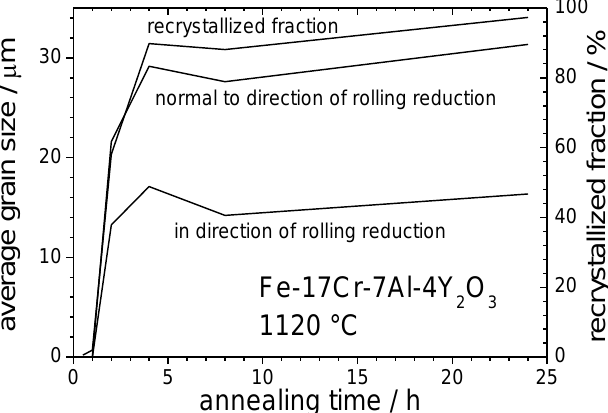
Figure 5. Evolution of the grain size normal and parallel to the rolling reduction and fraction of recrystallized area in the Fe-17Cr-7Al-4Y 2 O 3 system during annealing at 1120 °C.